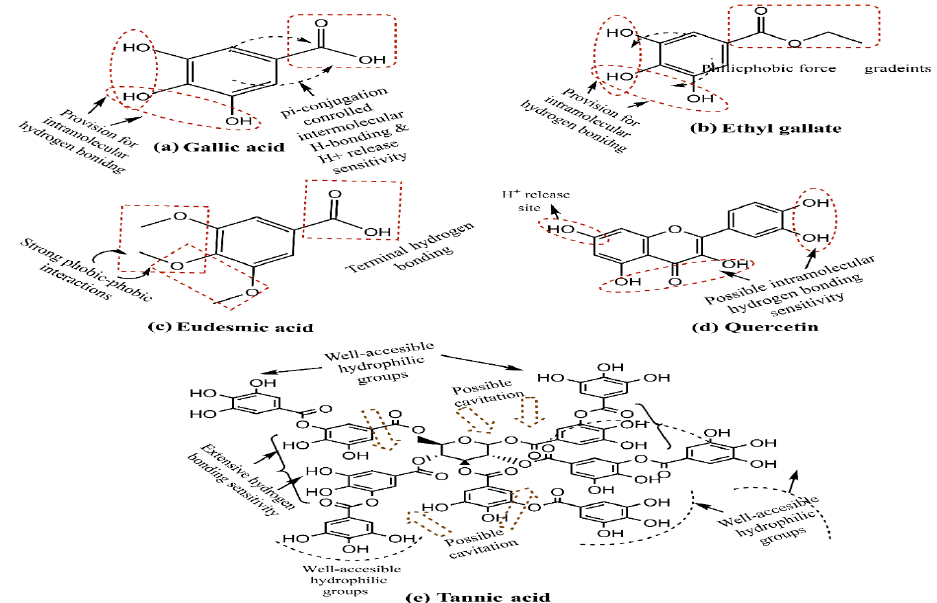
Figure 4. Structure-function dynamics of select templates for controlling particle sizes of mesoporous silica nanoparticles. It is usually that most of the used molecules exhibit plentiful hydrogen bonding interaction possibilities with ubiquitous – OH groups in their structure.